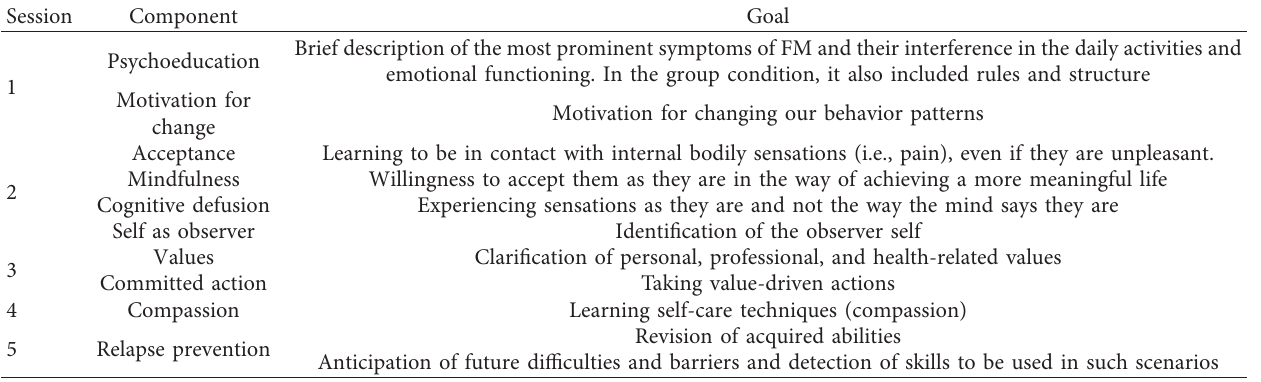
Table 1: Psychological components of the